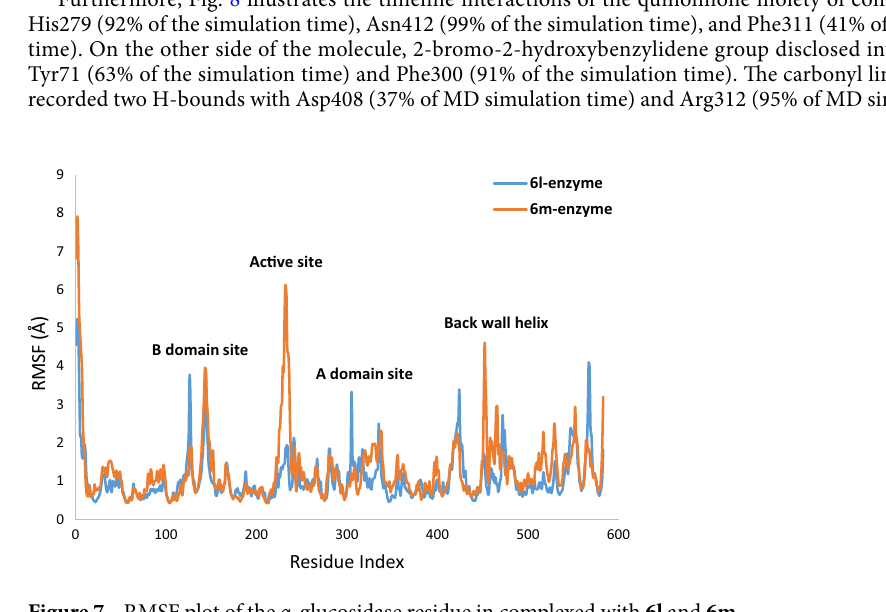
Figure 7. RMSF plot of the α-glucosidase residue in complexed with 6l and 6m .